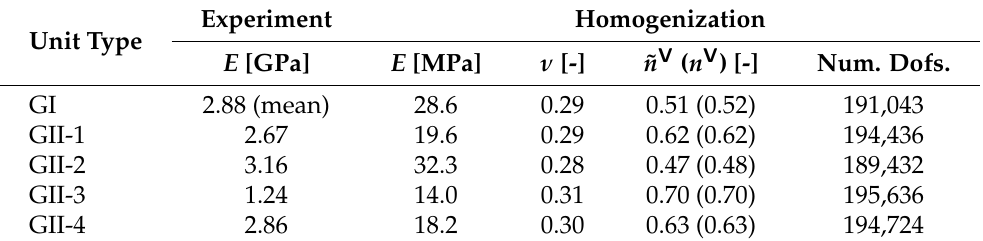
Table 10. Effective elastic properties of gyroid structures from